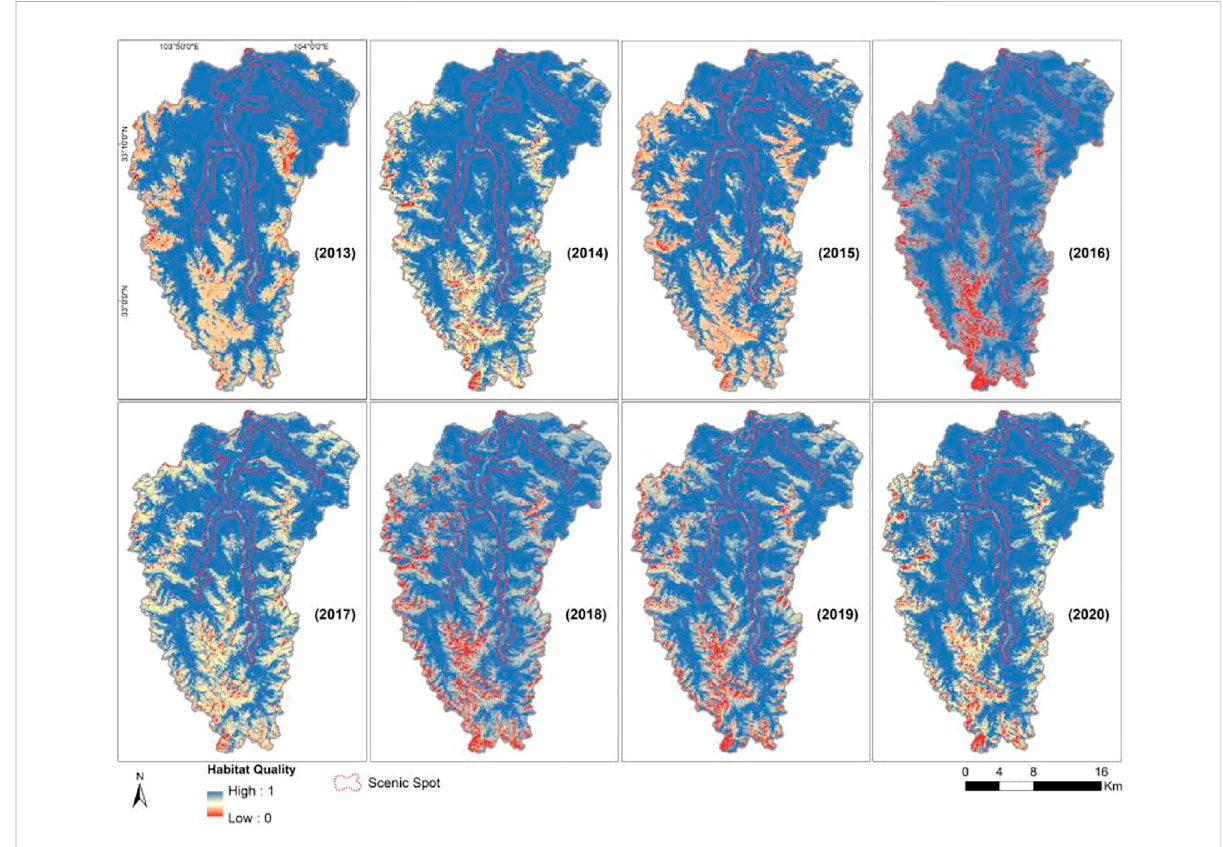
FIGURE 6 Spatio-temporal changes of habitat quality in